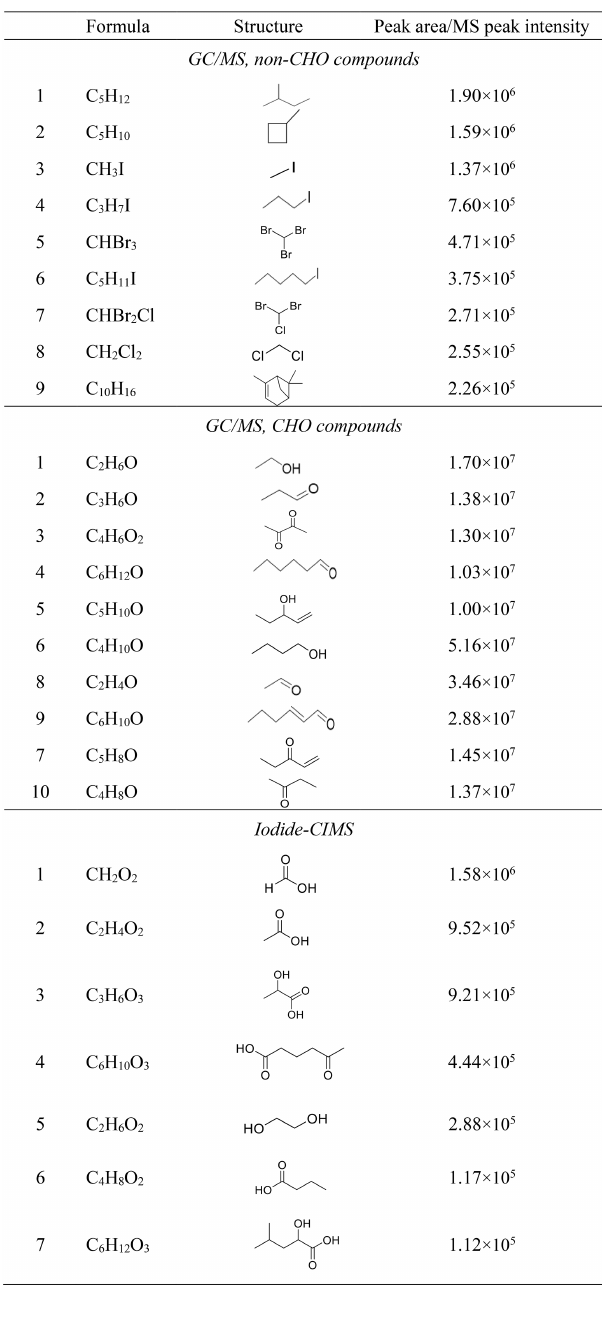
Table 1. Major volatile organic compounds emitted by macroalgae as potential NPF precursors, sorted by TIC peak area measured by GC/MS or MS peak intensity measured by the